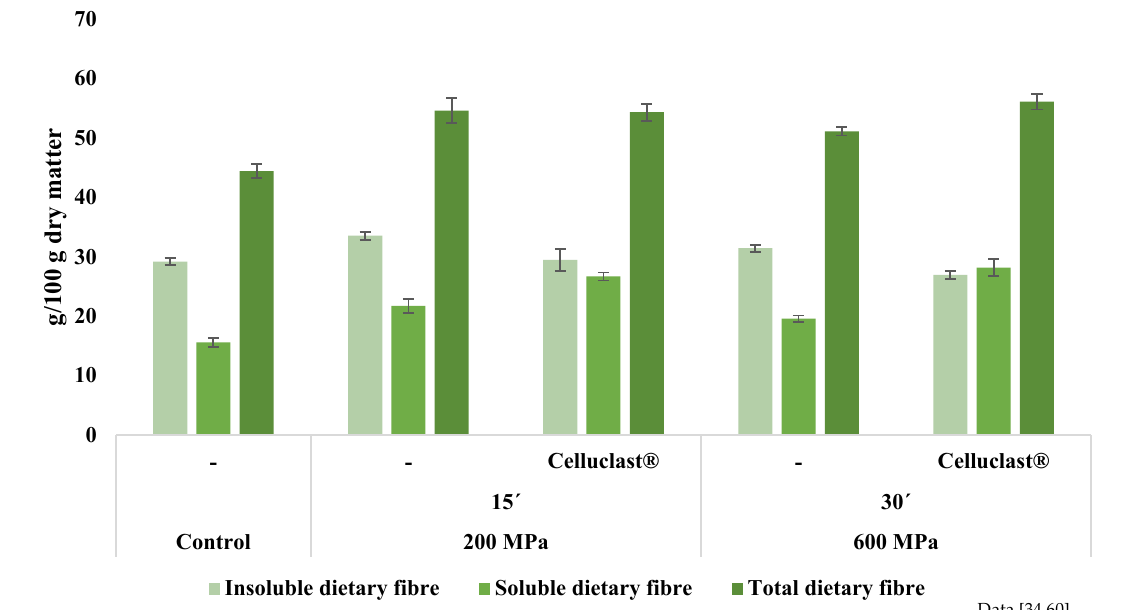
Figure 5. Determination of dietary fibre in apple by-product under high hydrostatic pressure at 200 MPa for 15 min and 600 MPa for 30 min, assisted and not assisted by Celluclast ® (92 EGU) enzyme. Data are expressed as g/100 g dry matter.